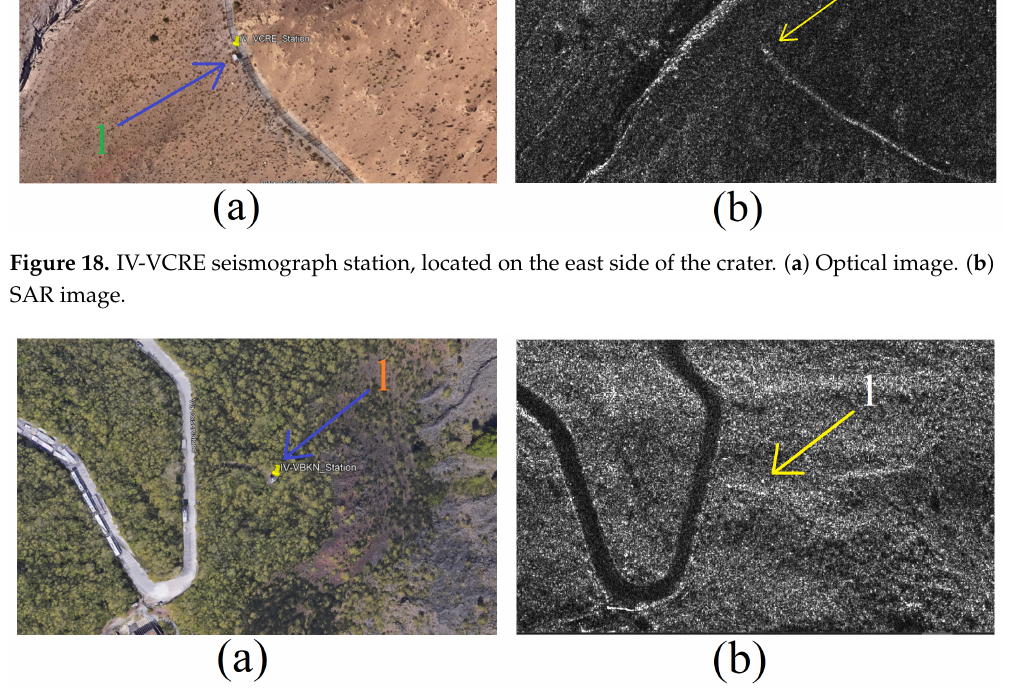
Figure 19. IV-VBKN seismograph station, located on the north side of the crater. ( a ) Optical image. ( b ) SAR